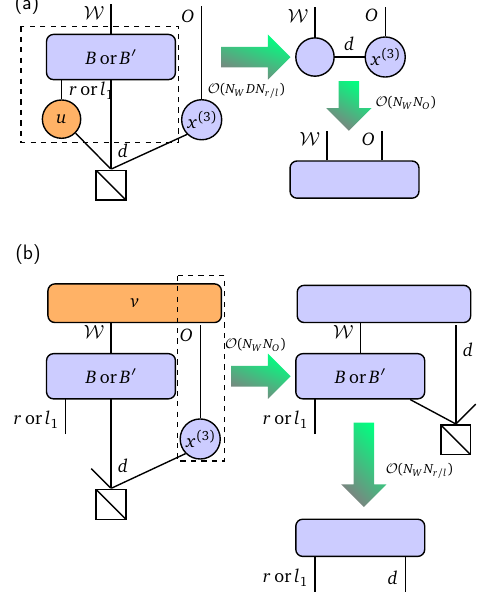
Figure 11: Graphical representations of tensor contractions for solving Eqs. (21) and (25), iteratively. The panel (a) illustrates the order of tensor contractions for computing Au and A (cid:48) u . The panel (b) illustrates the procedure for computing A † v and ( A (cid:48) ) † v . The computational complexity for each operation is